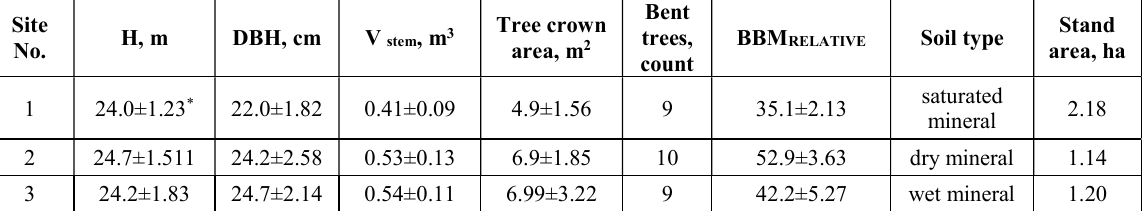
Table 1. Sample tree parameters. H – mean tree height; DBH – mean diameter at breast height; V – mean stem volume;